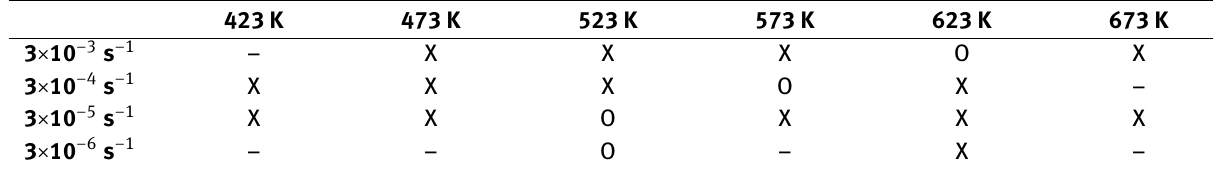
Table 2: Temperatures and strain rates at which serrations were observed at for AISI 431 martensitic stainless steel.